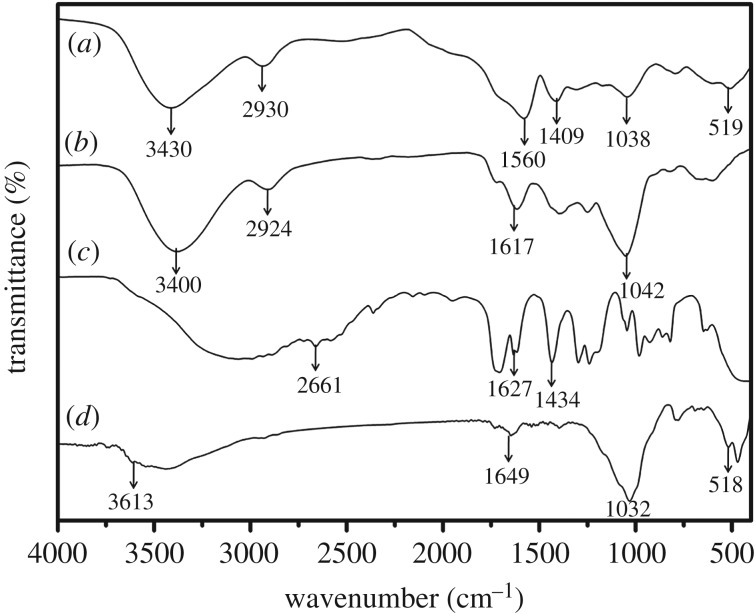
FTIR spectra of (a) SAPs, (b) MS, (c) AA and (d) PGS.